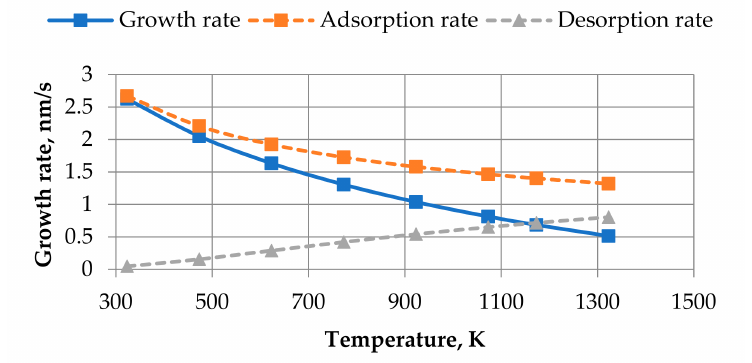
Figure 2. The dependence of total growth rate (solid line) on substrate temperature used in calculations. By dot lines, the partial components of growth rate (Equation (7)), adsorption, and desorption rates are